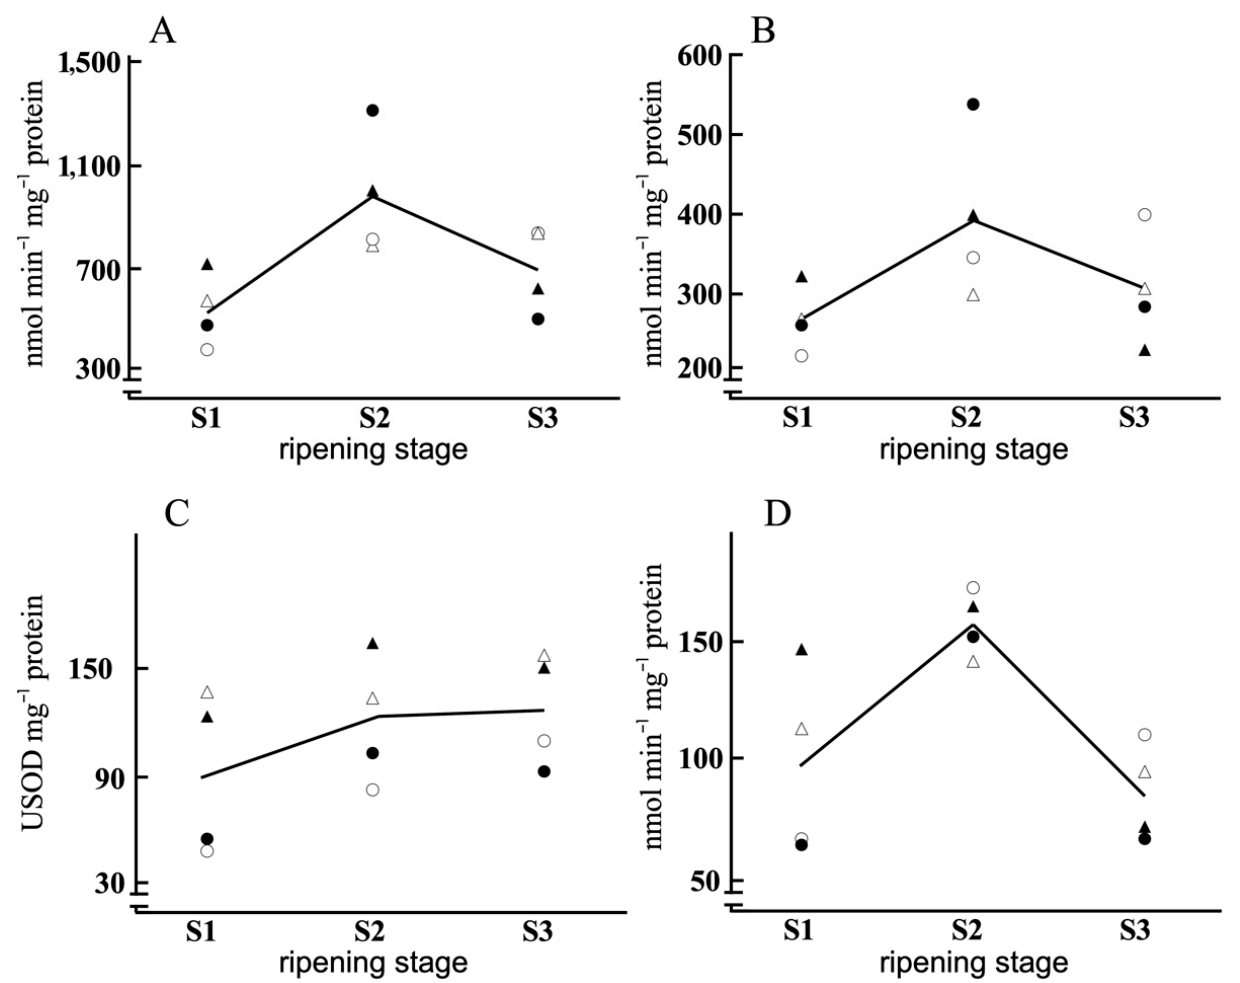
Figure 3. Line plots corresponding to NADH oxidation ( A ), O 2 − production ( B ) and SOD ( C ) and POX ( D ) activities of olives of Morisca NI – ● –, Morisca FI – ○ –, Manzanilla NI – ▲ – and Manzanilla FI – △ –, for each ripening stage (derived from Table S3).